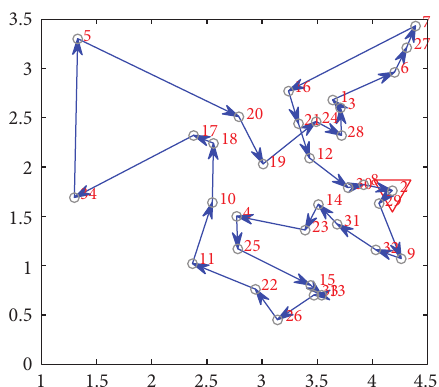
Figure 4: Cross-border logistics mode selection chart under multiobjective decision making.